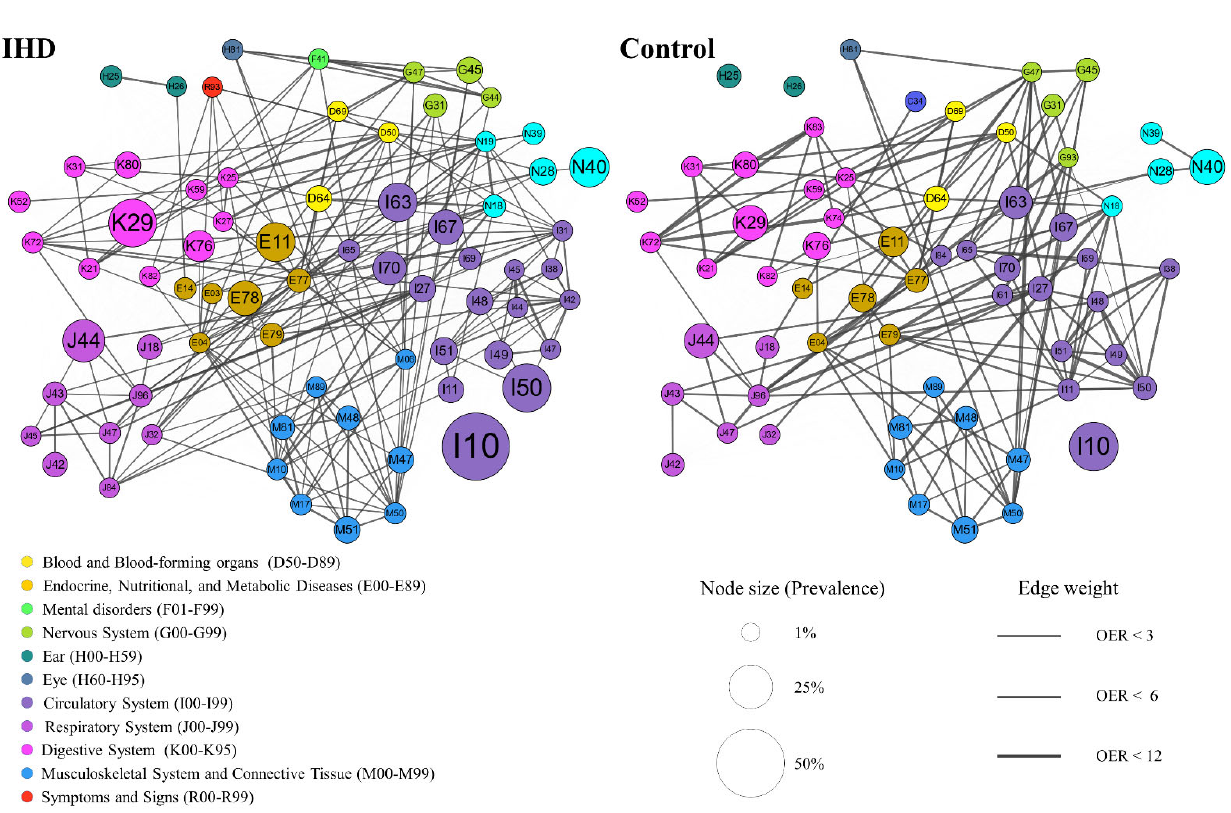
Figure 2. The strongest comorbidity associations in patients with IHD ( left panel) and controls ( right panel). Nodes represent comorbidities and are colored with disease chapters, node size indicates prevalence, and edge thickness represents observed-to-expected ratio (OER). Here, all statistically significant links where OERs > P90 are shown. Table 2. Metrics of PDNs in IHD patients and